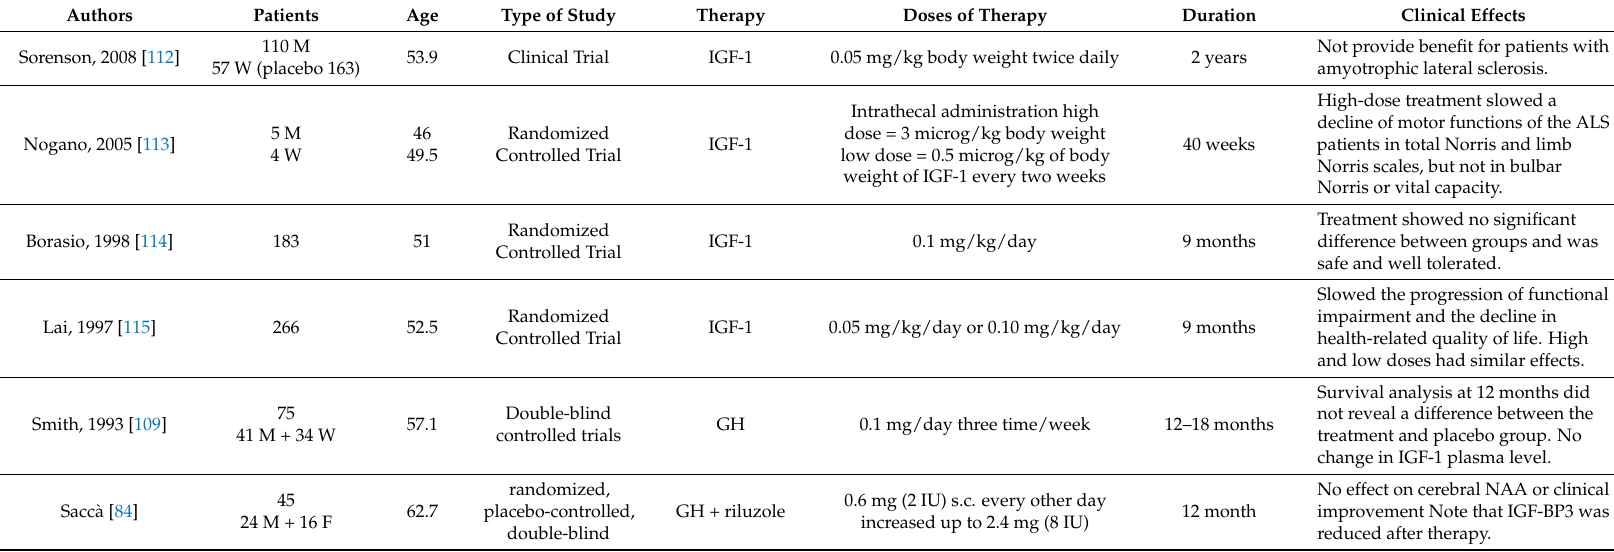
Table 2. Effect of rhIGF-1 and GH for the treatment of amyotrophic lateral